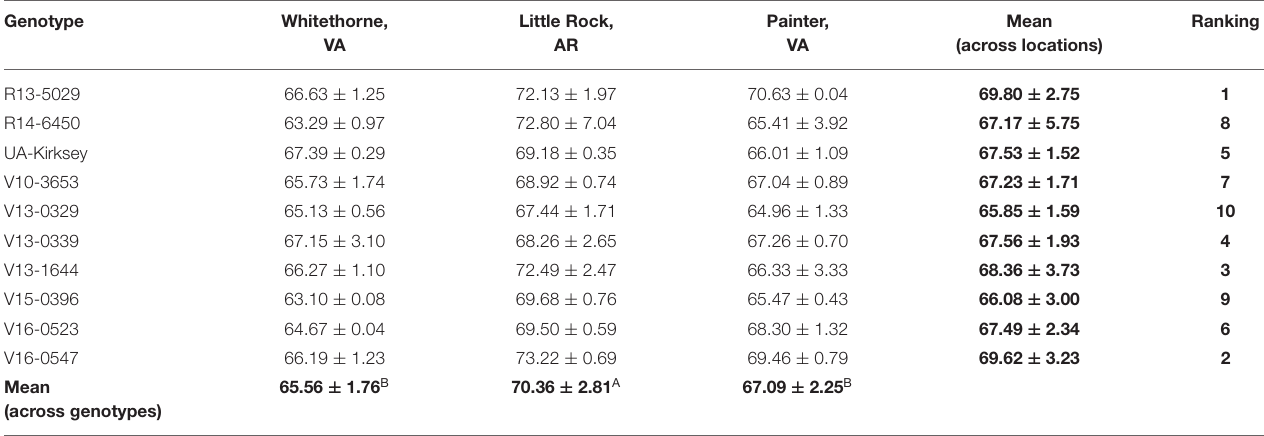
TABLE 11 | Moisture contents [%, wet basis (w.b.)] of fresh beans of 10 edamame genotypes planted in different locations.